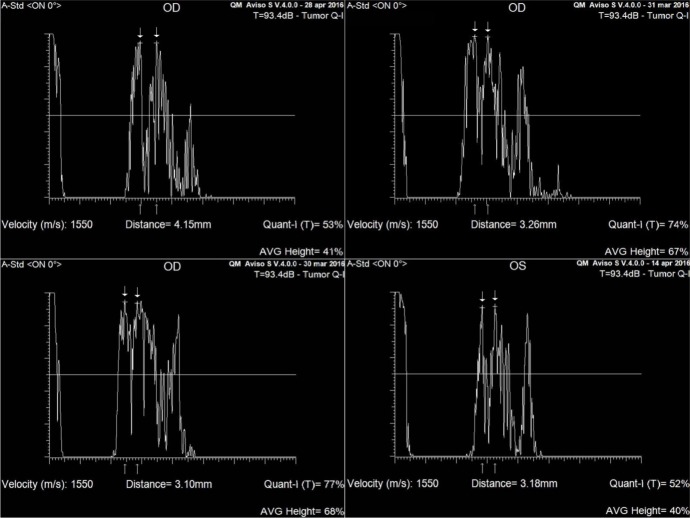
Echograms showing optic nerve subarachnoid space (ONSAS) measurements, using the standardized A-scan ultrasound in control group 1 and 2 in top row (left and right panel, respectively) and in glaucomatous group 1 and 2 in bottom row (left and right panel, respectively). The arrows over the peaks of the two high and perpendicular spikes, as shown in echograms, indicate the maximum arachnoid space diameter measured in the anterior third of the optic nerve.